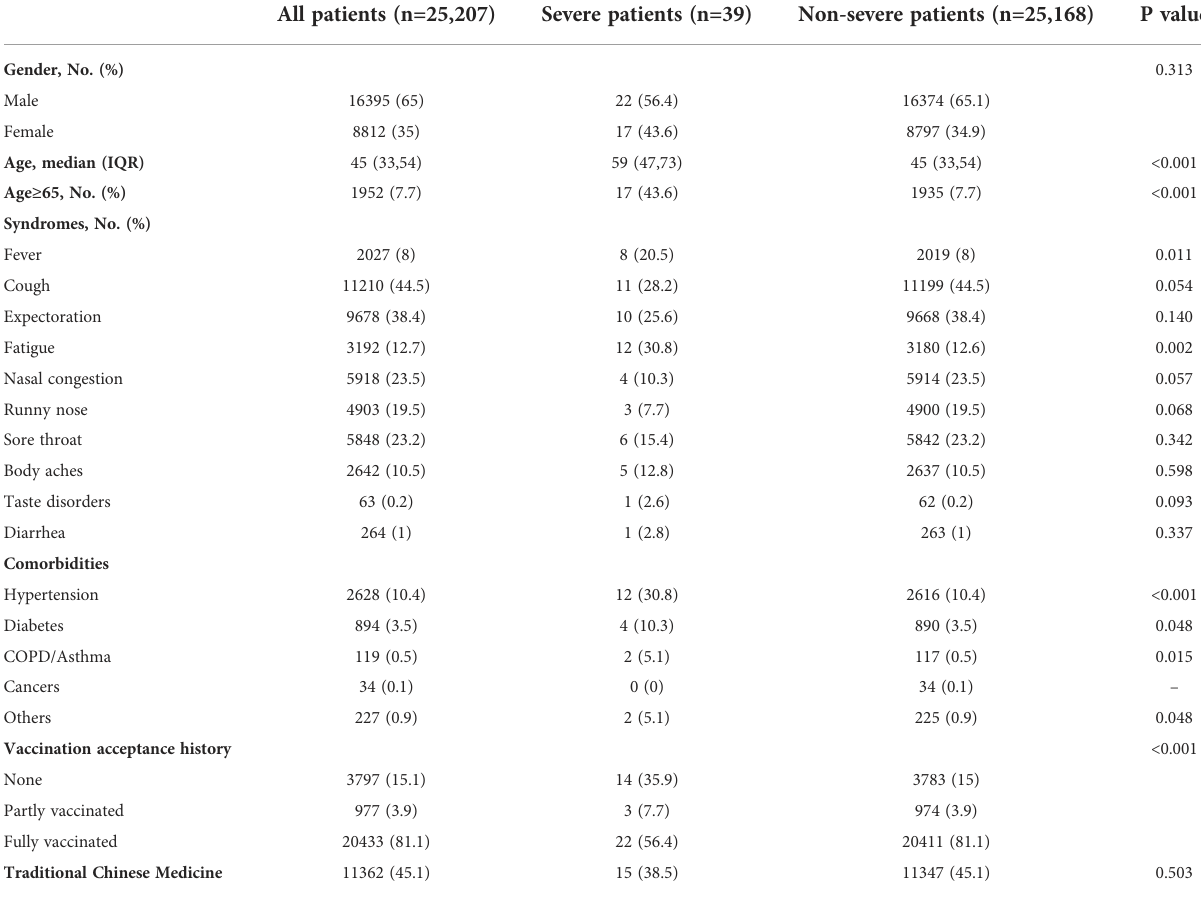
TABLE 2 Clinical characteristics of all COVID-19 patients infected by the omicron variant of SARS-CoV-2. All patients (n=25,207) Severe patients